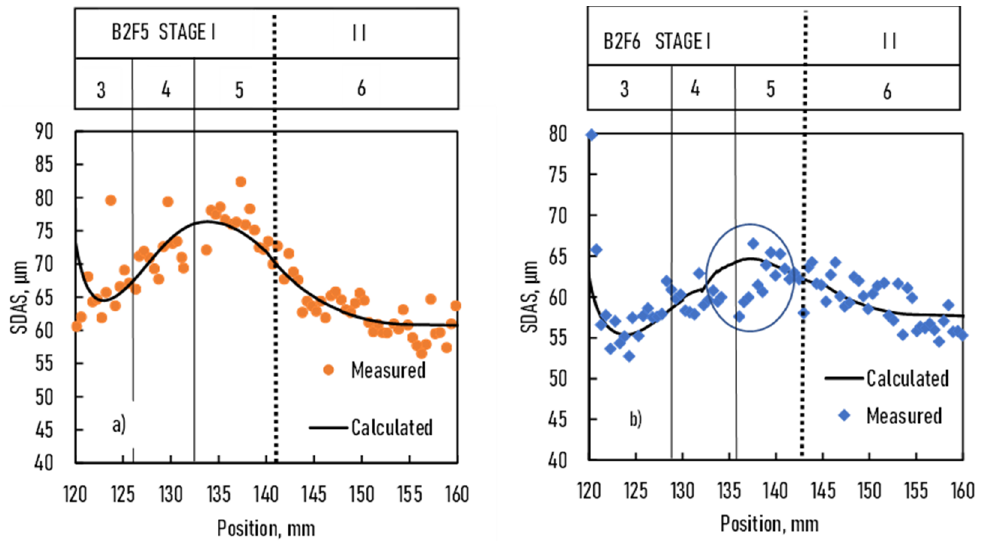
Figure 12. Secondary dendrite arm spacing of B2F5 and B2F6 samples vs. position in the sample ( a ): samples B2F1 and BF2, ( b ): samples B2F5 and B2F6.